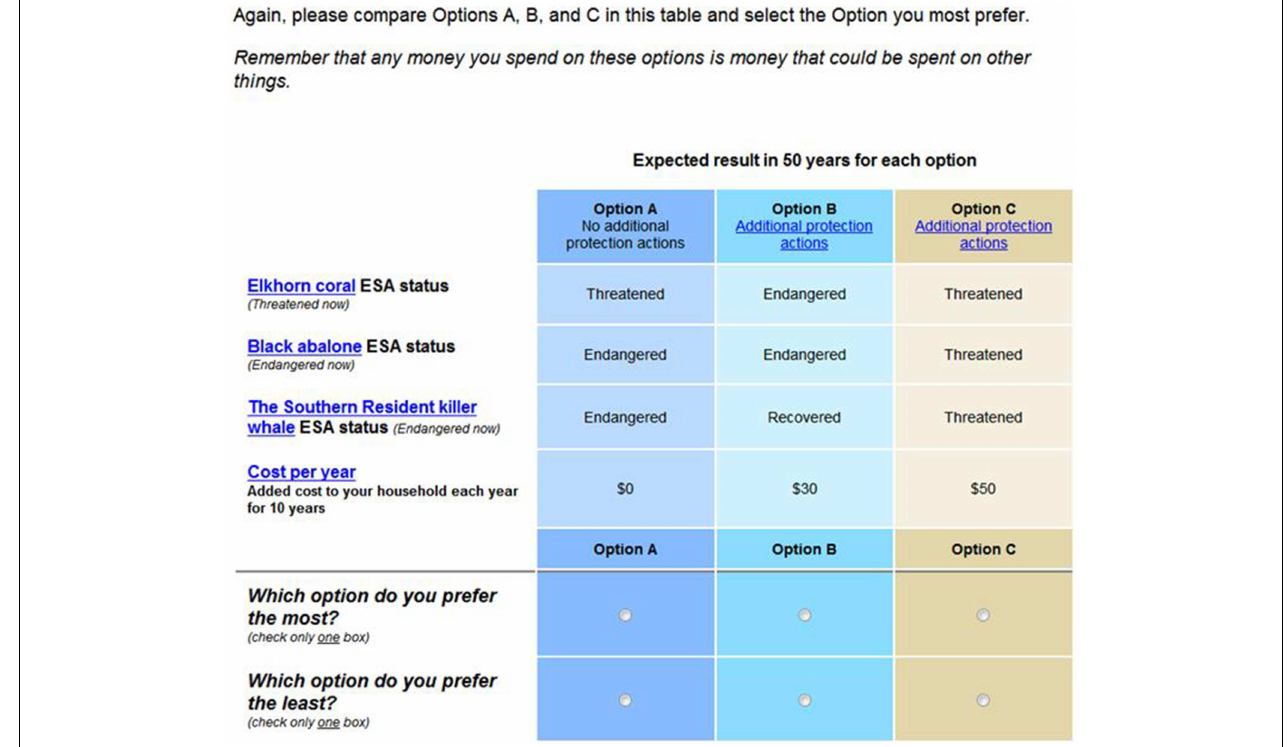
FIGURE 1 | Example of stated preference choice experiment